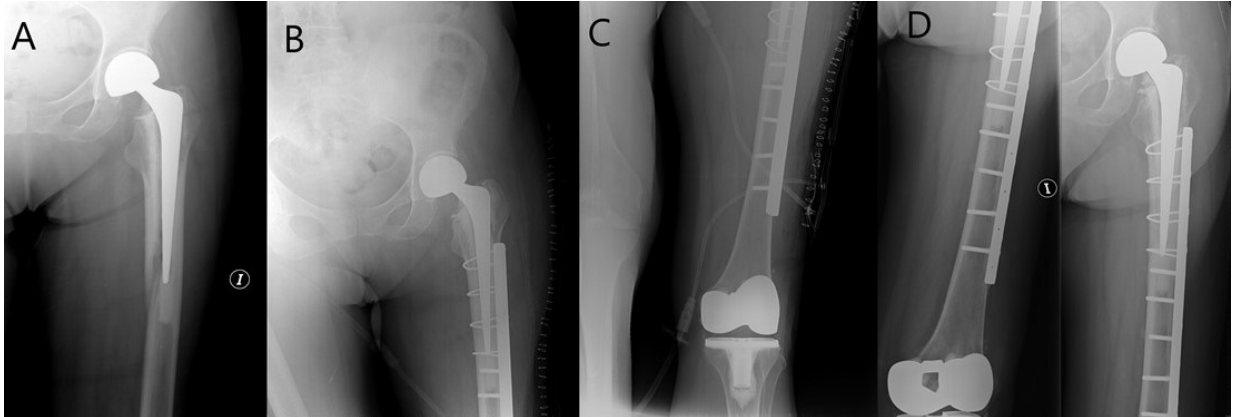
Figure 1. Woman 77 years old, Vancouver B2 PPHF treated using ORIF. ( A ) Fracture; (B, C ) postoperative control; ( D ) 4-year control.